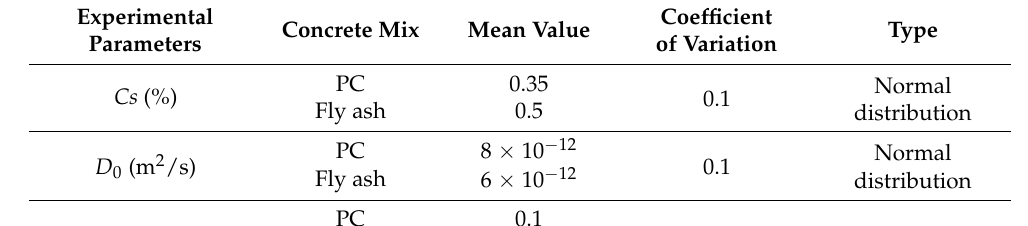
Table 1. Values of experimental parameters C s , D 0 , and m .